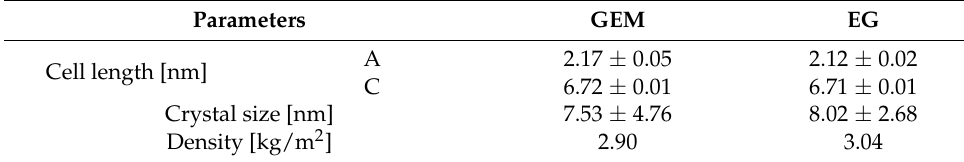
Table 2. Parameter from XRD